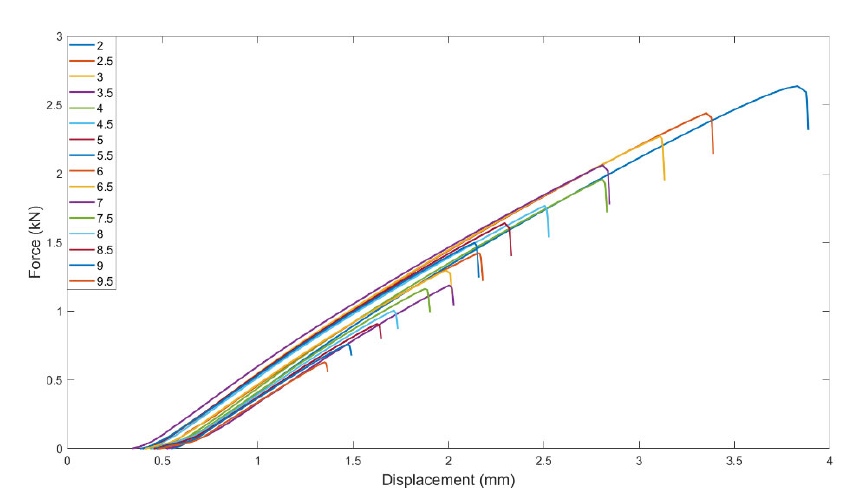
Figure 2. Force–displacement curves with different ligaments.